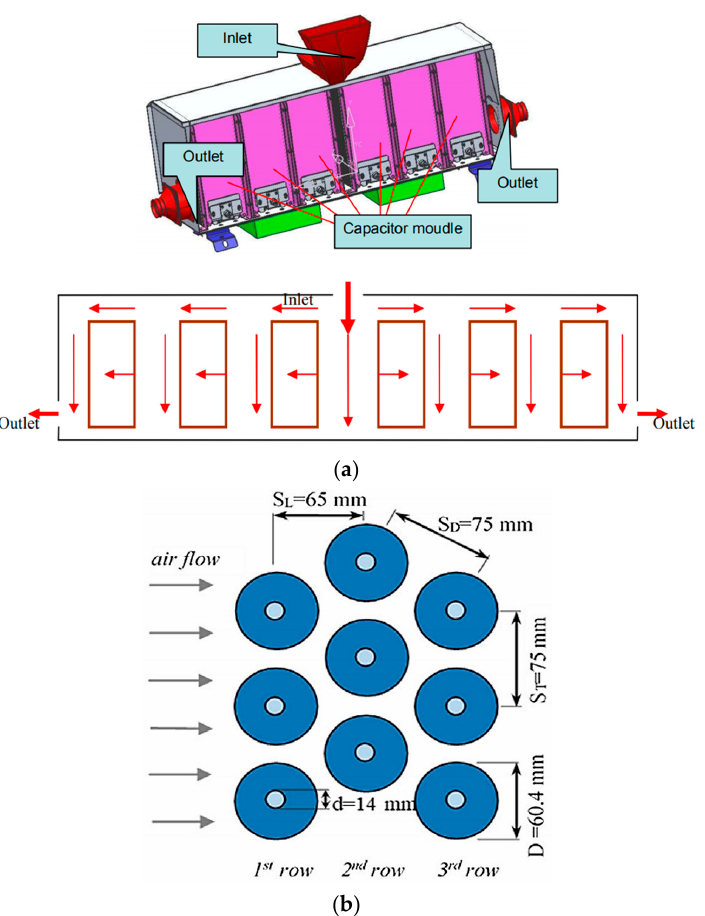
Figure 15. ( a ) Connection in series and parallel configuration diagram where red arrows represent the direction of gas flow [42], open access. ( b ) The SC’s staggered layout, reproduced with permission from [154]. Copyright 2019, Elsevier